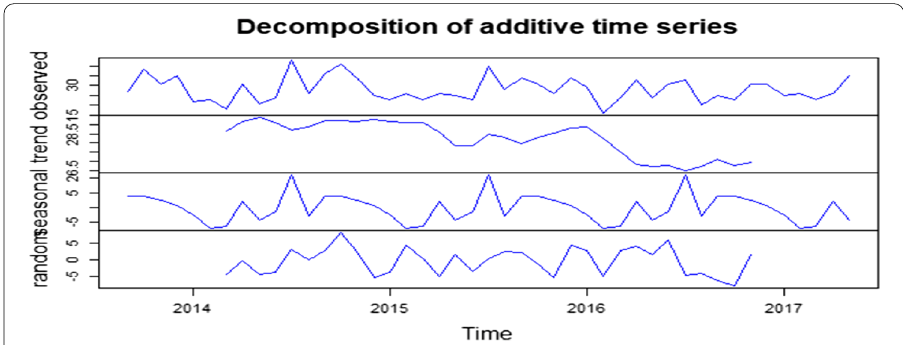
Fig. 2 Time series decomposition of injury RTA data